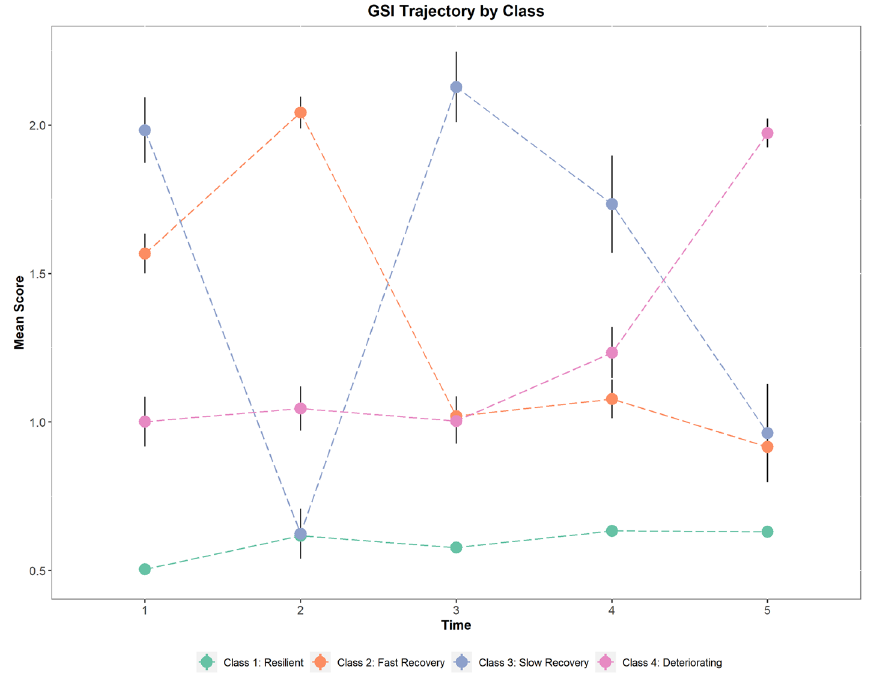
Figure 2. Estimated mean Psychological Distress (GSI) score from the four-class solution of the Growth Mixture Model over time. Each class indicates a specific trajectory during the pandemic. Error bars represent standard